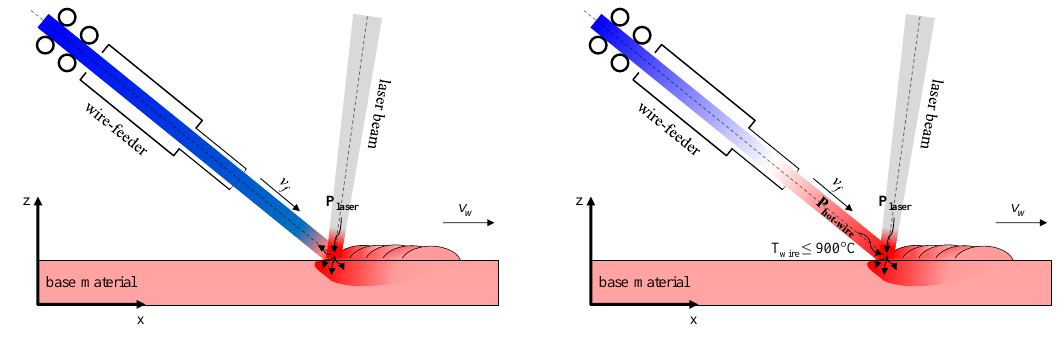
Figure 1. Strategies for decoupling of heat sources: use of conventional ( left ) and hot-wire technology ( right ).